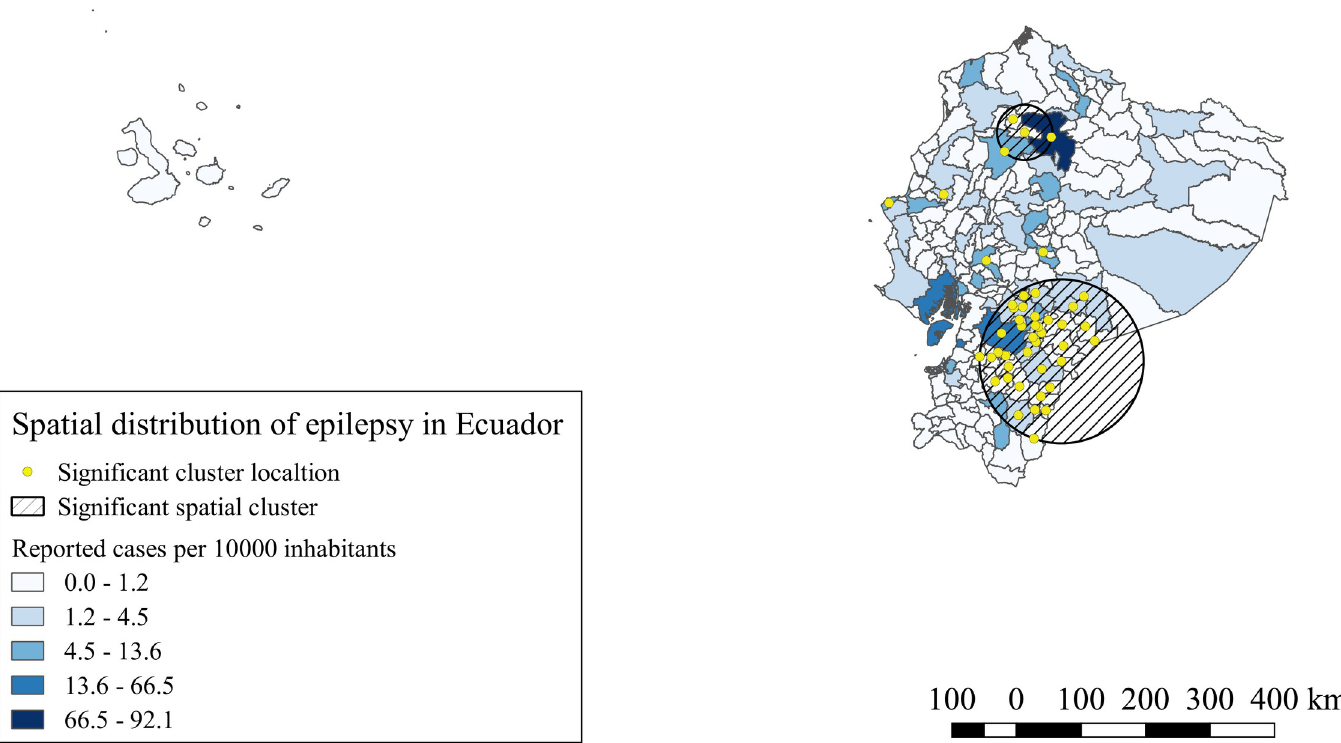
Fig 2. Spatial distribution and significant space clusters of epilepsy hospitalized cases in Ecuador. Shape files for this map were obtained from INEC portal [51].